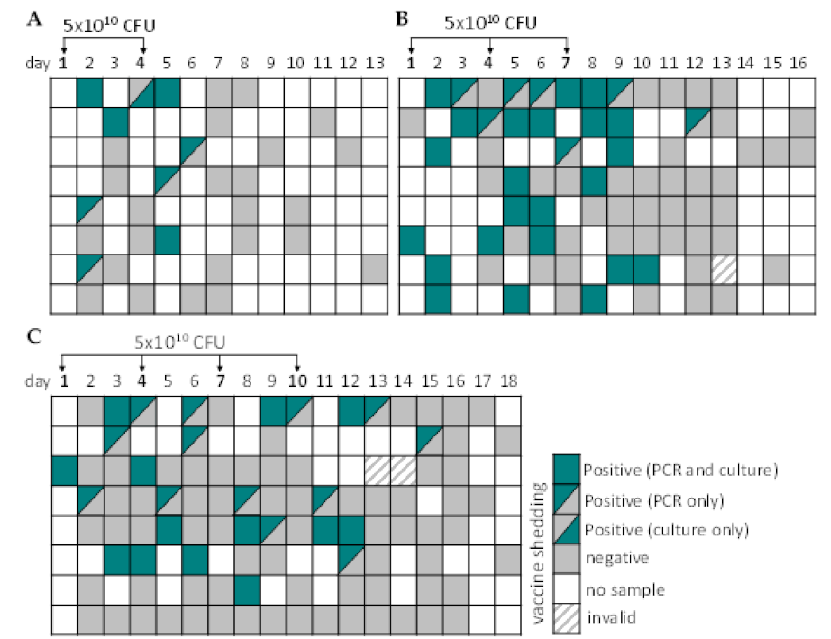
Figure 3. Vaccine shedding in stool after multiple oral vaccinations with ShigETEC. Stool sam- ples were obtained as available from subjects who received ( A ) two, ( B ) three or ( C ) 4 doses of 5 × 10 10 CFU ShigETEC and were assessed for the presence of vaccine strain by PCR and culturing. PCR was considered invalid, when two independent 16S rDNA PCR assays yielded negative results and repeated DNA extraction was not possible due to small sample amount. Each line corresponds to one subject.